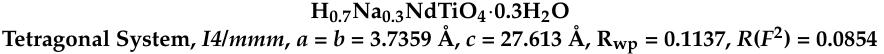
Figure 3. Experimental (red), calculated (green) and differential (purple) profiles of the H 0.7 Na 0.3 NdTiO 4 · 0.3H 2 O XRD pattern. Table 1. Results of the H 0.7 Na 0.3 NdTiO 4 · 0.3H 2 O structure calculation based on XRD data.